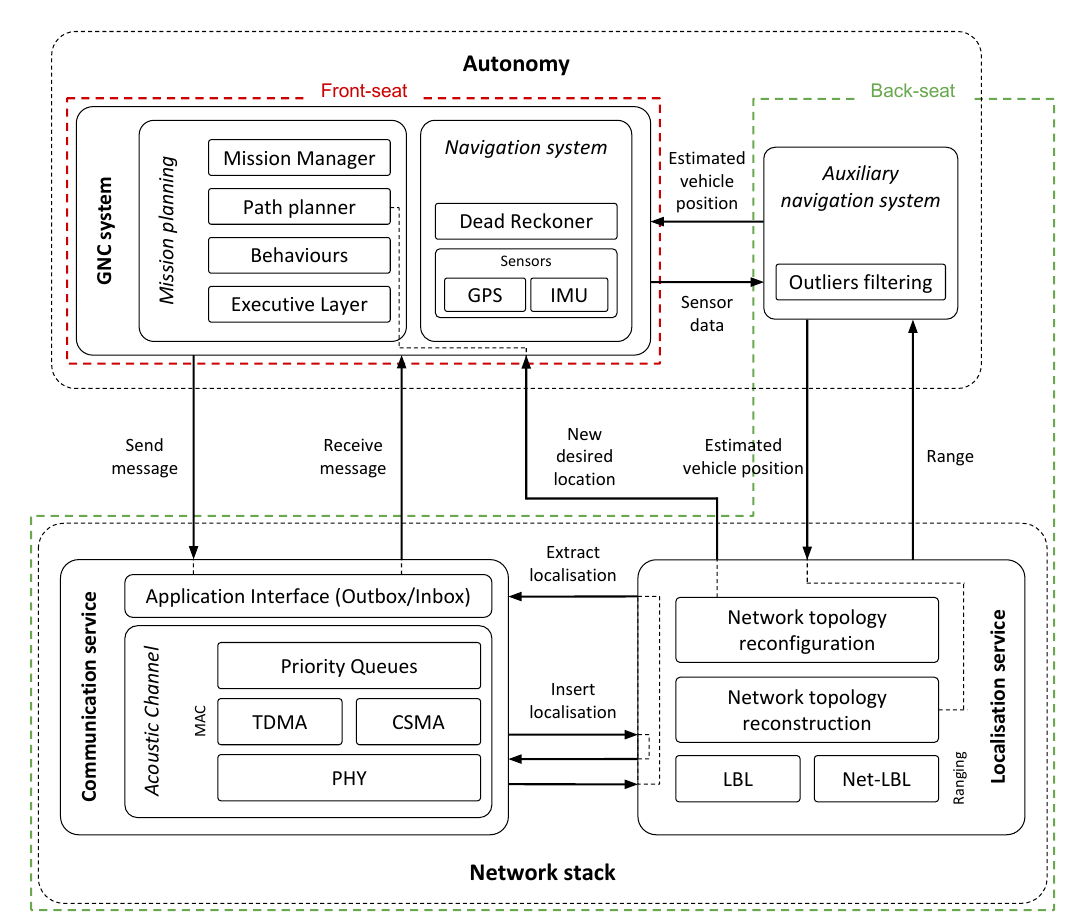
Figure 8. A customisation of the architecture proposed in Figure 7 for the Low-Cost AUV Technology (LCAT) project. The communication module provides the autonomy system with access to the acoustic channel, as well as with range measurements through the localisation service. The network stack can issue new waypoint requests to the path planner of the autonomy system (which includes a goto-waypoint service) in order to change the location of the